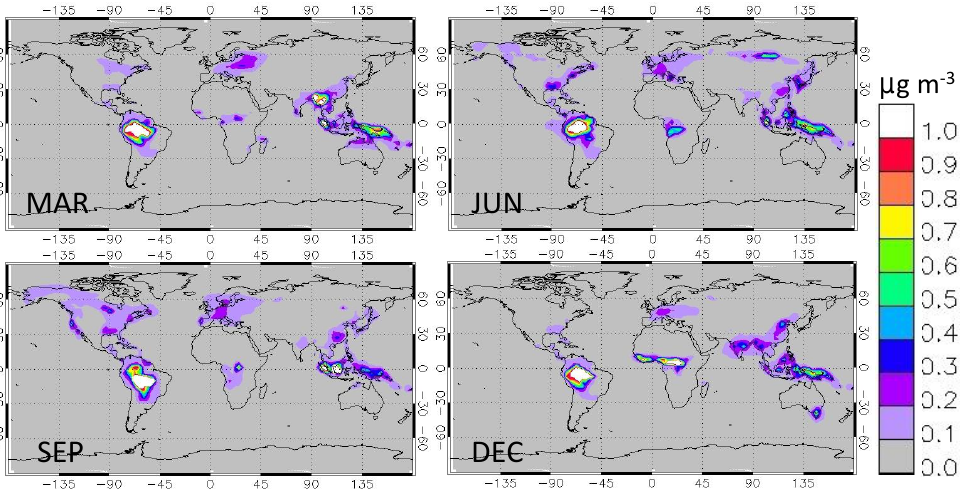
Fig. 1. Global distributions of monthly average SOA concentrations (µg m -3 ) at the surface predicted in the base-case MOZART-4 runs for March, June, September and December of 2006.